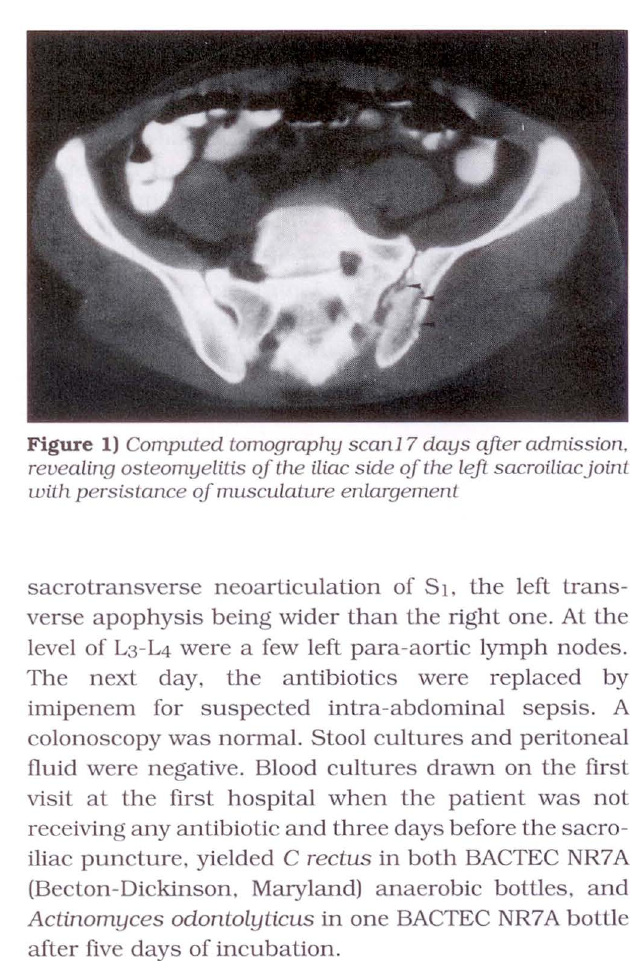
sacrotransverse neoarticulation of S1. the left